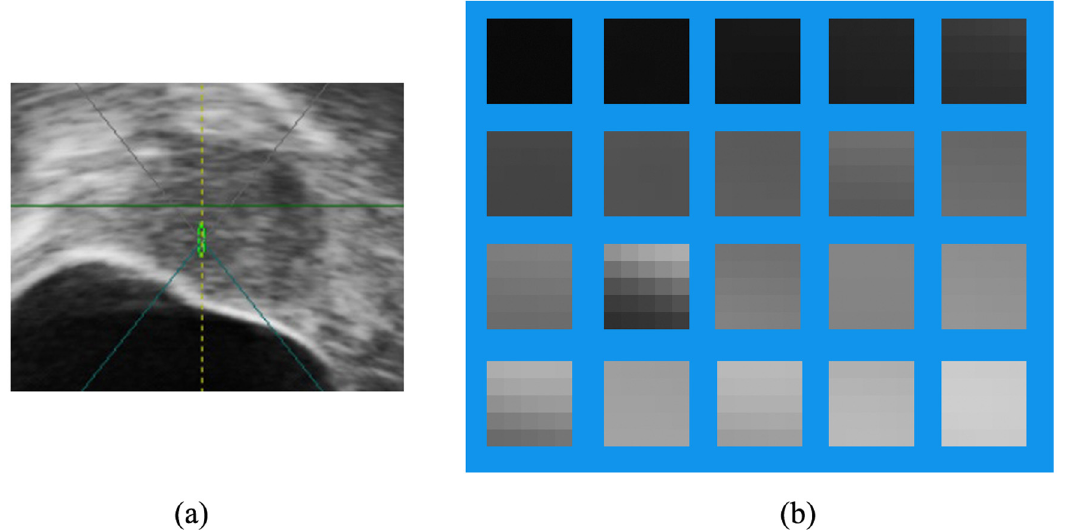
Fig 6. Examples of textons. (a) The image. (b) 20 corresponding